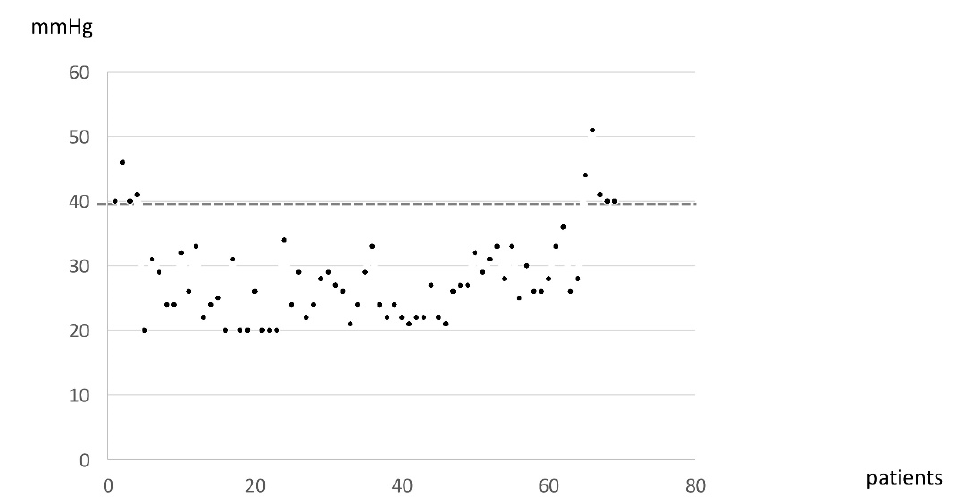
Figure 2. The distribution of SPAP estimated by Doppler echocardiography in GD patients. Nine patients (13%; median age 66 years, range 53–75 years) presented baseline echocardiographic signs suggesting PH. Five of these patients had undergone splenectomy (median age 64 years, range 59–75 years) and the other four had an intact spleen (median age 69 years, range 63–74 years; p = 0.1209). The mean SPAP in this group was 41 mmHg. The characteristics of GD patients with PH are summarised in Table 2.